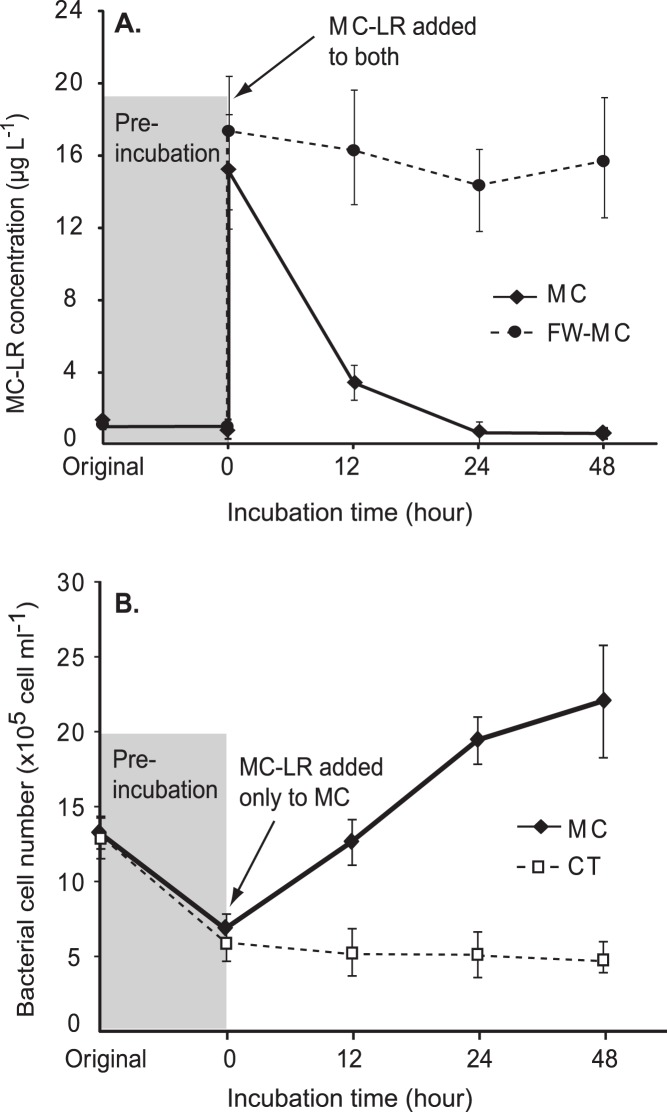
Variation of MC-LR concentration and total bacterial cell number during microcosm incubation.(A) Average MC-LR concentrations and standard deviations in the MC and FW-MC microcosms. (B) Average bacterial abundance and standard deviations in MC and CT microcosms. Shaded areas indicate periods of pre-incubation with inorganic N and P for establishing carbon-limited conditions in microcosms.